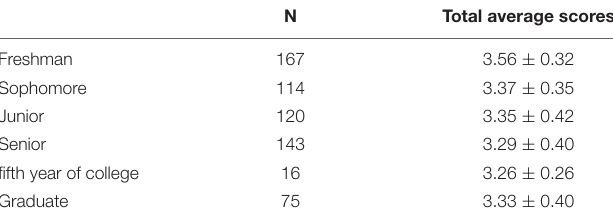
TABLE 5 | Medical students’ professional identity scores in different